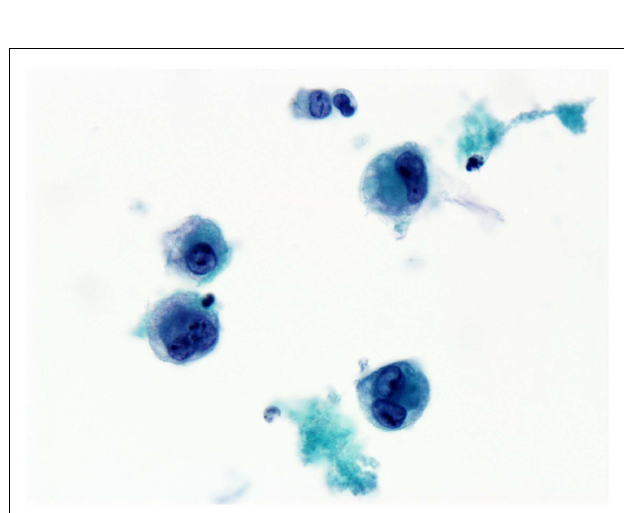
FIGURE 2 | Effusion fluid (seroma) . Anaplastic large cells present in the effusion surrounding the breast implant. Anaplastic large cells also involve the breast implant capsule (not shown). Immunohistochemical staining shows anaplastic large-cell lymphomaT-cell type.